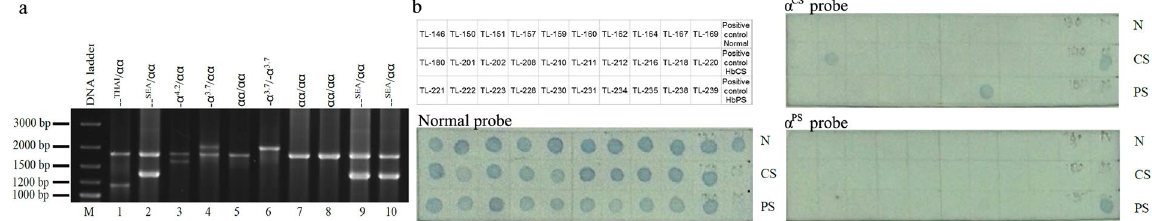
Figure 1. Six common α -thalassaemia types detected by multiplex-gap PCR and dot-blot hybridization techniques. ( a ) PCR products after alpha-globin gene analysis using the multiplex gap-PCR methodology, M = DNA marker, lane 1–4 = positive controls of alpha-globin heterozygotes which are -- THAI / αα , -- SEA / αα , - α 4.2 / αα and - α 3.7 / αα in order, lane 5 = negative control ( αα / αα ), lane 6 = unknown sample genotyped as - α 3.7 homozygote, lanes 7–8 = unknown samples genotyped as normal and lanes 9–10 = unknown samples genotyped as -- SEA heterozygotes (A cropped gel is shown). The full-length gel is presented in Supplementary Figure S1. ( b ) Dot-blot hybridization analysis of the Lue ethnic group. Samples TL-201 and TL-234 were genotyped as α CS heterozygotes. No samples were positive for α PS (A cropped blot is shown). The full-length blot is presented in Supplementary Figure